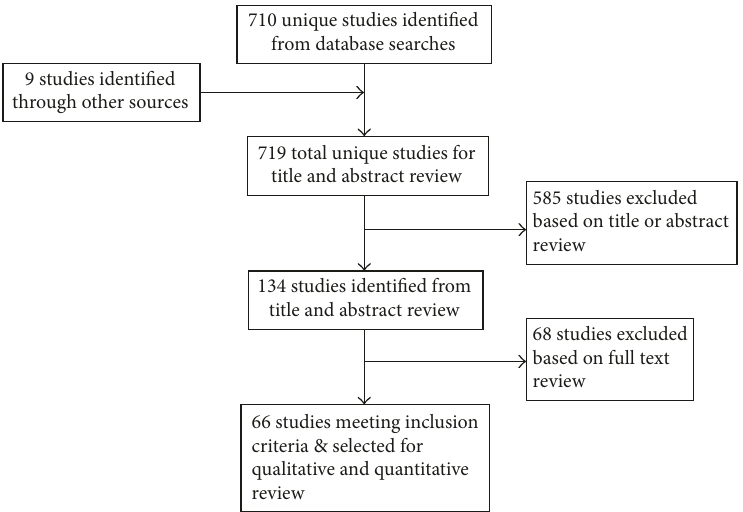
Figure 1: Systematic literature review and selection flowchart used to assess efficacies of various bone